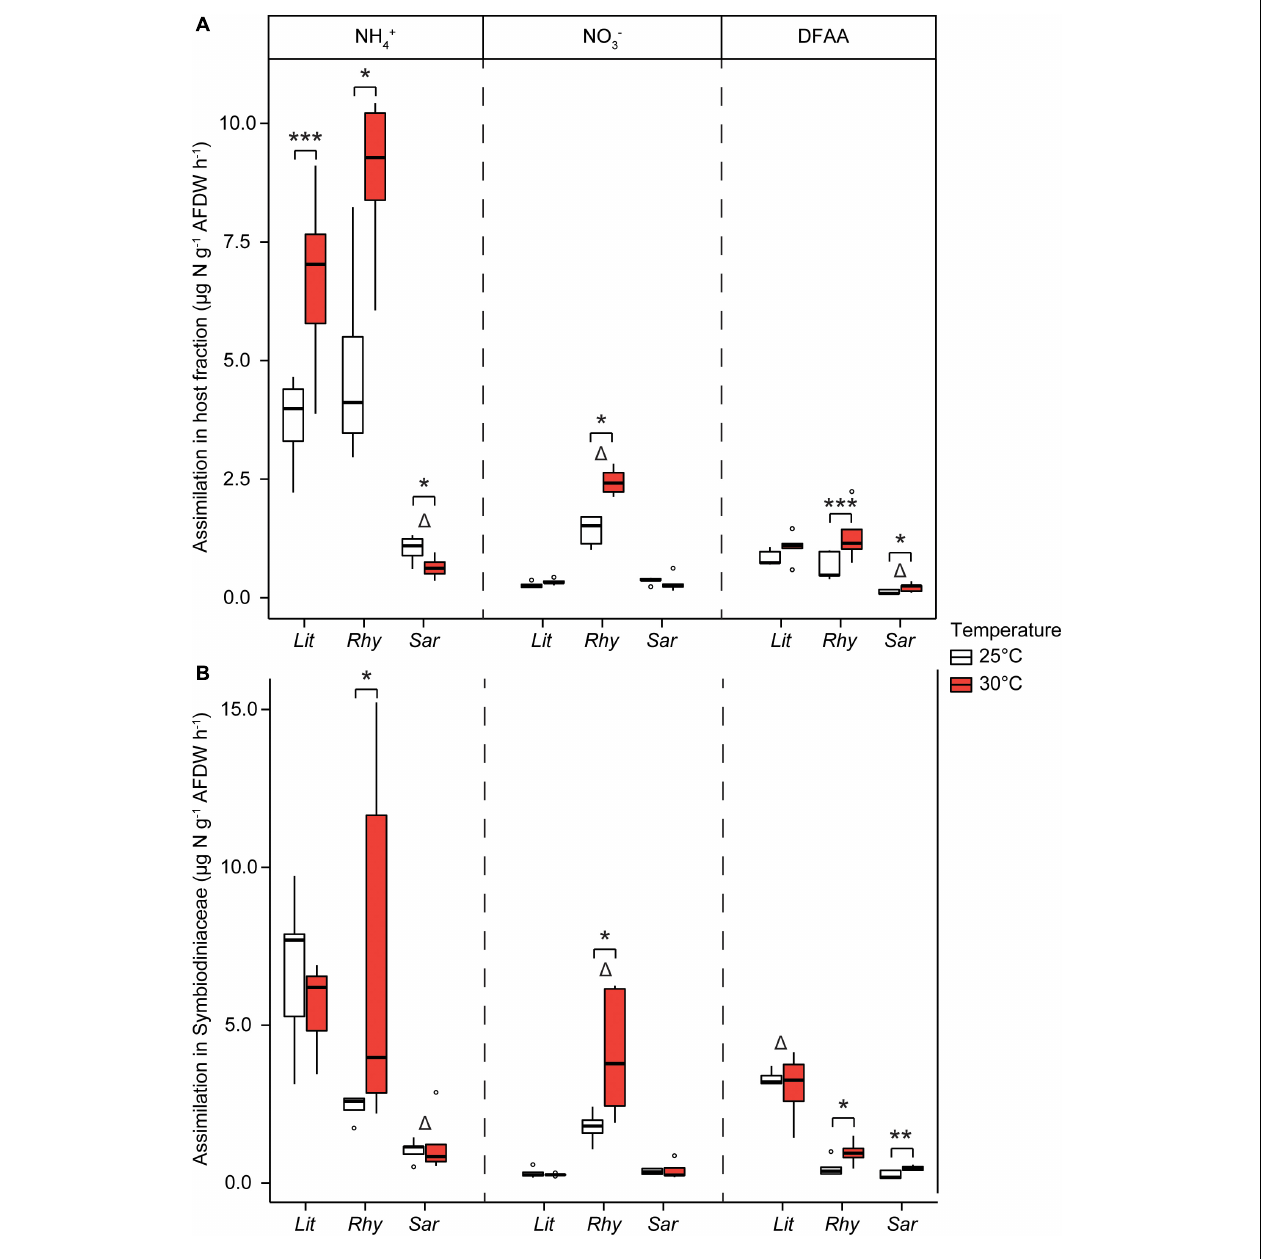
FIGURE 7 | Assimilation rates of dissolved N in shallow soft corals exposed at two temperatures, in (A) the host tissue and (B) the Symbiodiniaceae fraction [ Litophyton arboreum (Lit), Rhytisma fulvum fulvum (Rhy), Sarcophyton sp. (Sar)]. Significant differences between temperatures are displayed with asterisks (* for p < 0.05; ** for p < 0.01; *** for p < 0.001). (cid:49) shows the species that differentiates from the other two within its group (i.e., either host or Symbiodiniaceae fraction, for a single N source). AFDW = ash-free dry weight. DFAA = dissolved free amino acids. ns = not